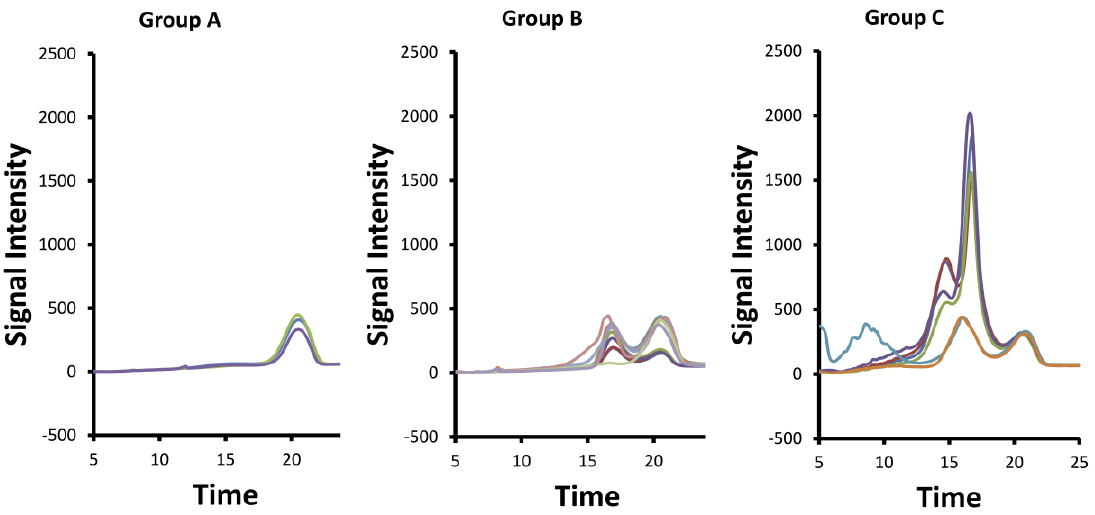
Figure 5. The 5 min to 25 min portion of the strong anion exchange HPLC (SAX-HPLC) chromatograms with UV detection at 215 nm of crudes differentiated into groups A, B, and C by NMR data as shown in Figure 2. Generally, the lower resolution HPLC method shows these groups have increasing levels of different impurities, going from group A to B to C,